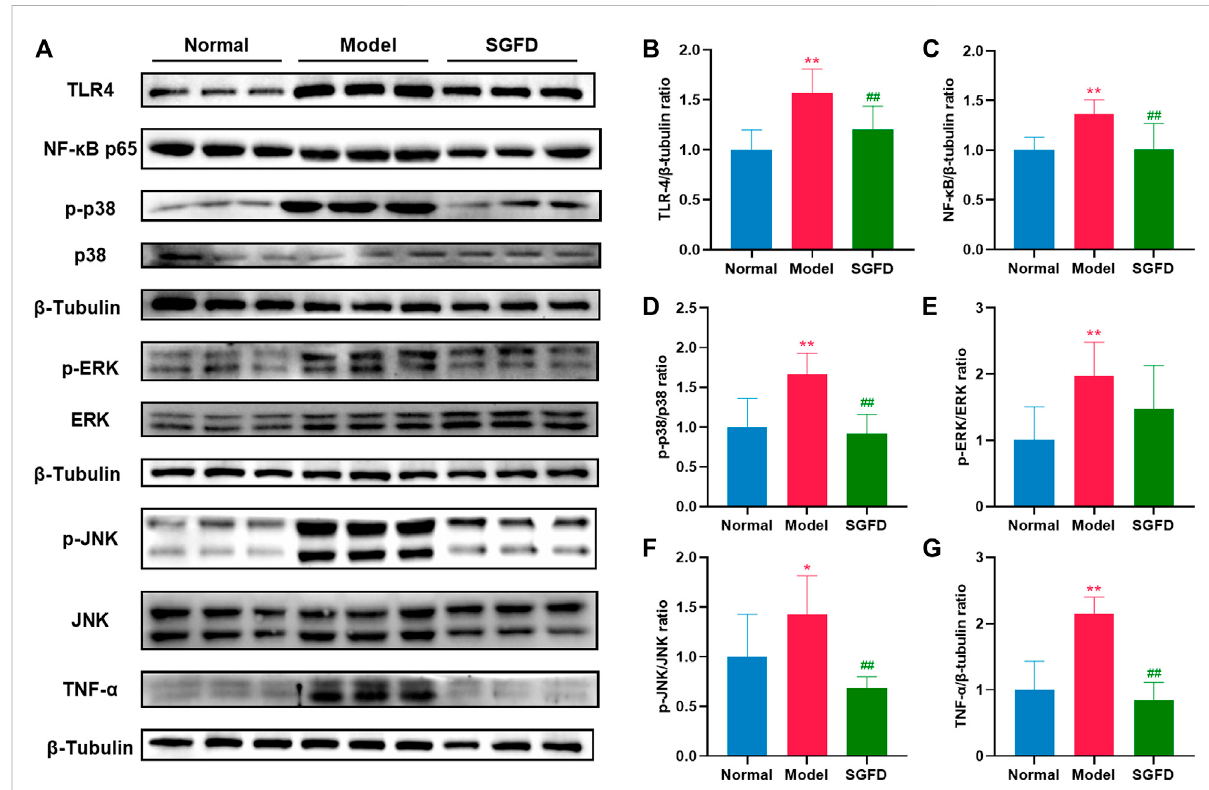
FIGURE 9 SGFD treatment suppressed TLR4/NF- κ B/MAPKs pathway. (A) . Western blotting assay was performed to measure the expression of TLR4, NF- κ B p65, JNK, p-JNK, ERK, p-ERK, p38, p-p38 and TNF- α in synovial tissues of knee joints (B – G) . Relative expression of TLR4, NF- κ B p65, p-p38/p38, p-ERK/ERK, p-JNK/JNK and TNF- α were quanti fi ed. Data were shown as mean ± SD ( n = 3). * p < 0.05, ** p < 0.01 vs. normal group; # p < 0.05, ## p < 0.01 vs. model